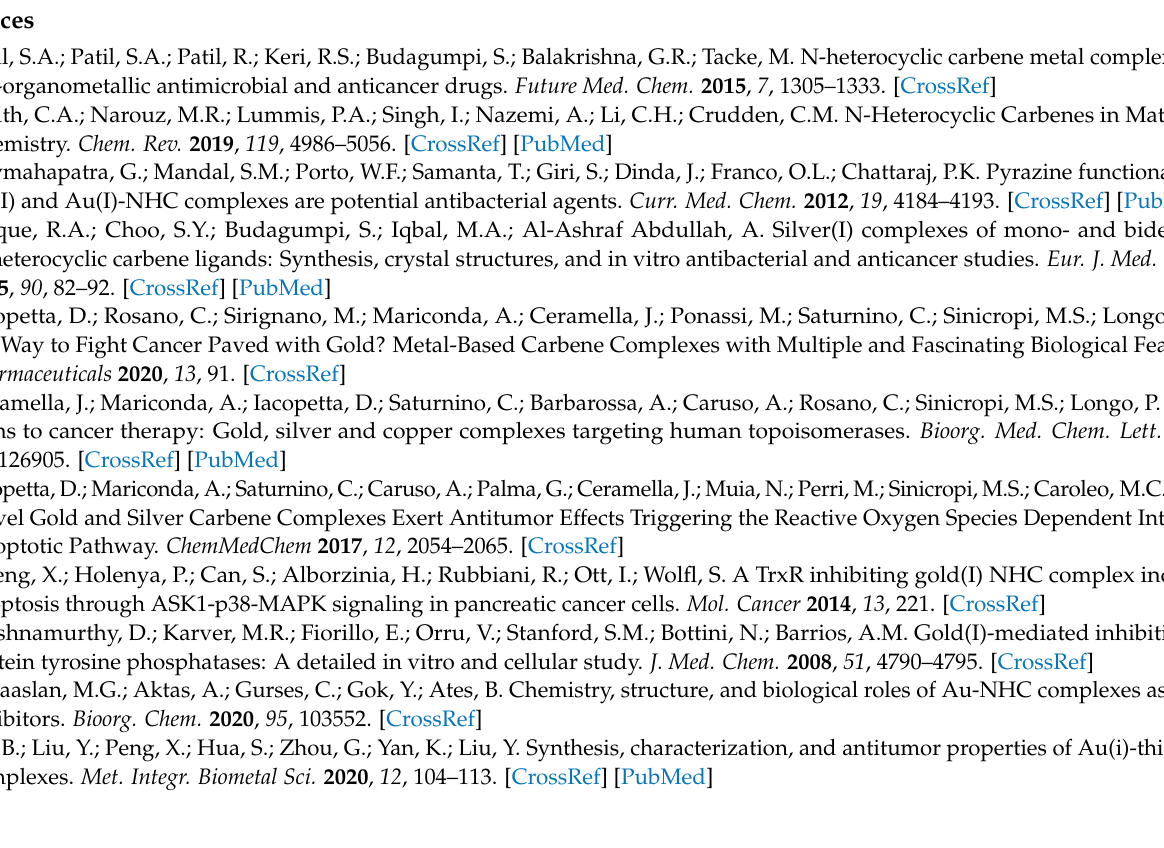
in MCF-10A cells, I : Figure S5. Mitochondria staining and cytochrome c detection in MCF-10A cells, L : Figure S6. NF- κ B expression in MCF-10A